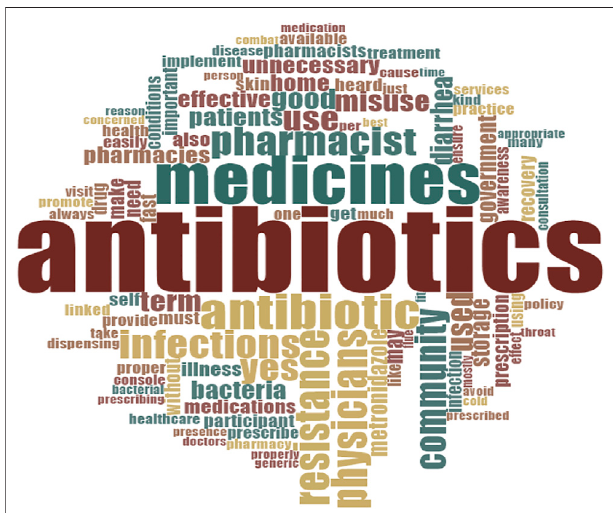
FIGURE 4 | Word cloud diagram depicting the antibiotics use and the perceptions of the participants related to antibiotic use and antibiotic